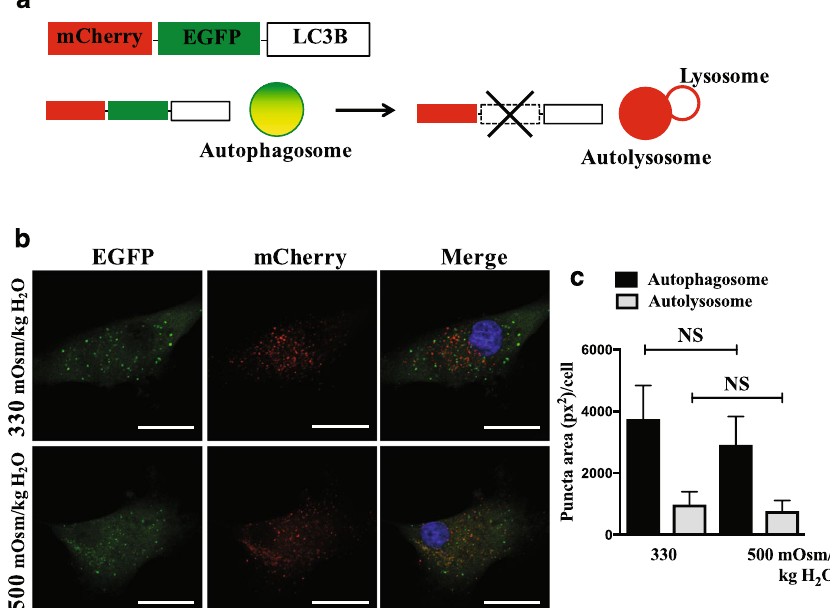
Figure 6. Number of autophagosomes and autolysosomes do not change by hyperosmolarity in NP cells. ( a ) Schematic diagram of tandem mCherry-EGFP-LC3B plasmid. Autophagosomes in the NP cells expressing mCherry-EGFP-LC3B are tagged with both fluorophores and therefore appear yellow/green. When these autophagosomes fuse with lysosomes, acid labile EGFP signal is lost, leaving mCherry signal (red), which measures autophagic flux. ( b ) NP cells transduced with retrovirus expressing a tandem mCherry-EGFP-LC3B construct cultured under either iso- or hyperosmotic condition showed that the numbers of autophagosome (yellow/green puncta) and autolysosome (red puncta) did not change by hyperosmolarity. Scale bar: 25 μ m. ( c ) Quantification of puncta area per cell using Colocalization Plugin of ImageJ software confirmed the insensitivity of autophaigc flux to hyperosmotic stimulus. At least 27 cells per group imaged at 126x magnification from 10 random microscopic fields were used for quantification analysis. Bars represent mean ± SEM (n = 3). Student t test was used to determine statistical significance. NS,